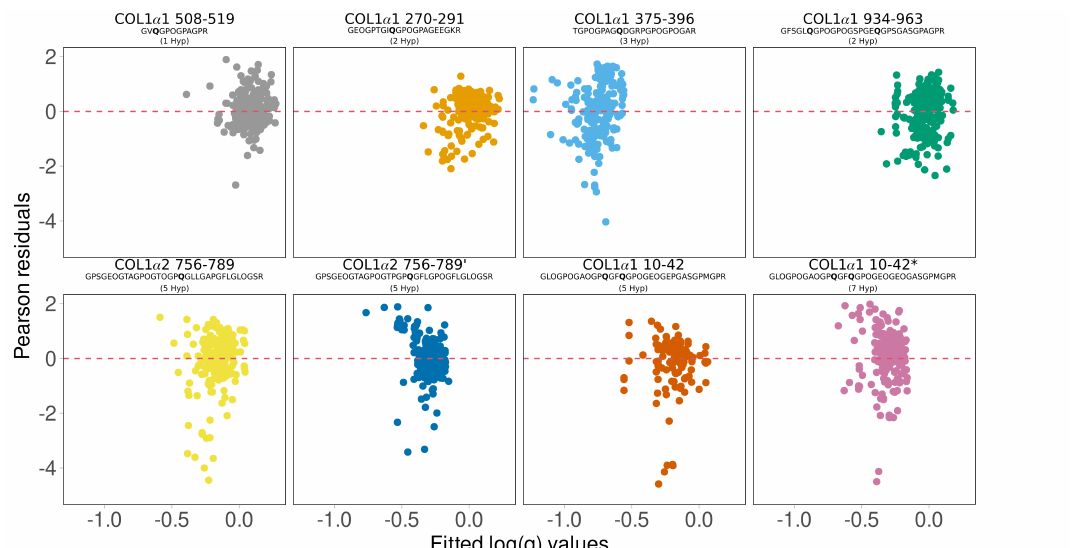
Figure 3. Residual plots between fitted values and Pearson residuals for a) COL1 ↵ 1 508-519, b) COL1 ↵ 1 270-291, c) COL1 ↵ 1 375-396, d) COL1 ↵ 1 934-963, e) COL1 ↵ 2 756-789, f) COL1 ↵ 2 756-789’, g) COL1 ↵ 1 10-42 (5 Pro Hyp), and h) COL1 ↵ 1 10-42* (7 Pro Hyp), explores the model fitting quality. Random distribution ! !